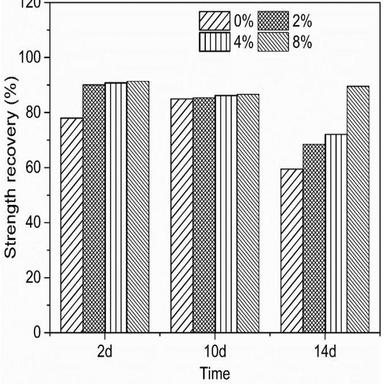
Strength recovery of specimen with different content of autolytic mineral microspheres.